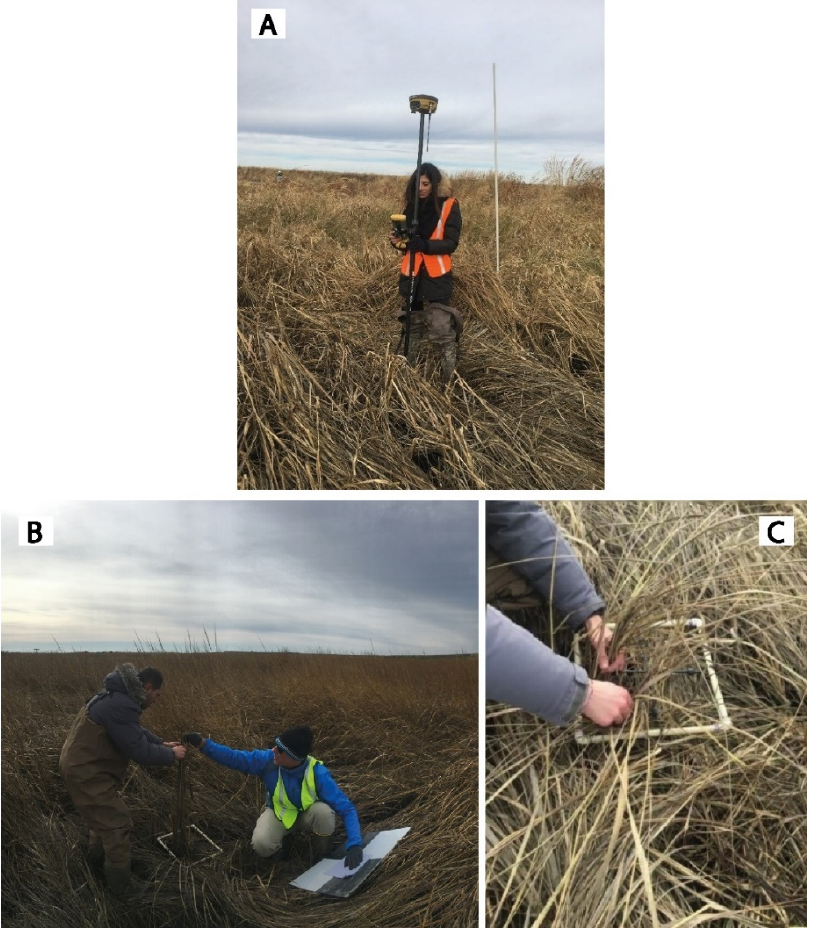
Figure 2. ( A ) GNSS ground survey in RTK mode on November 2019; ( B ) measurement of stem height; ( C ) measurement of stem density with a quadrat.